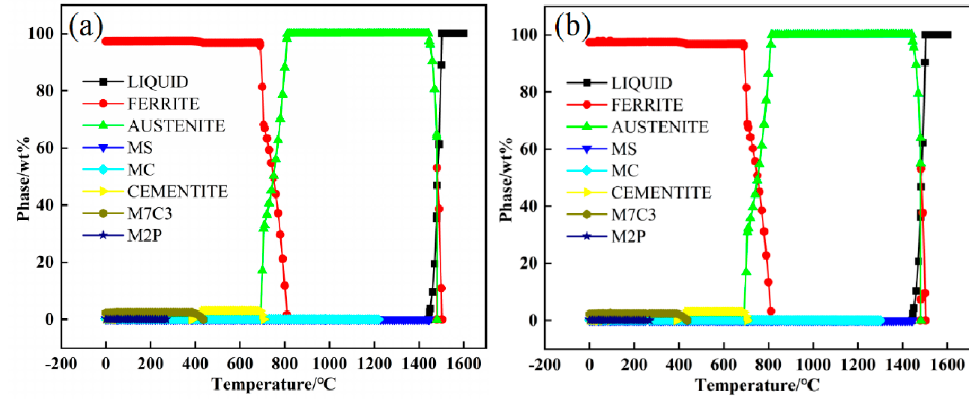
Figure 3. Thermodynamic evolution of the phases determined using JMatPro software: ( a ) steel 1#, ( b ) steel 2#.